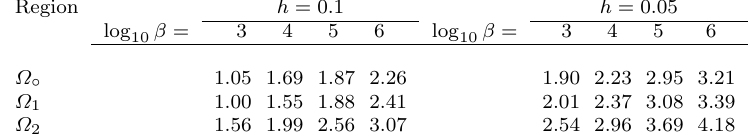
Table 1. Comparing − log 10 ( r.l.s.e ) errors for δt = 0 . 01 by different parameters β and h for uniform gird points and different domains. Region h = 0 . 1 h = 0 . 05 log 10 β =